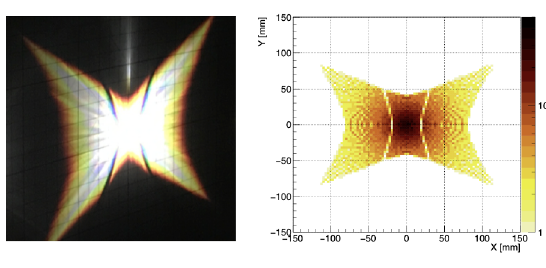
Figure 3. Left: Shape of spot around the focal plane. Right: Reproduced spot shape by raytracing simulation.